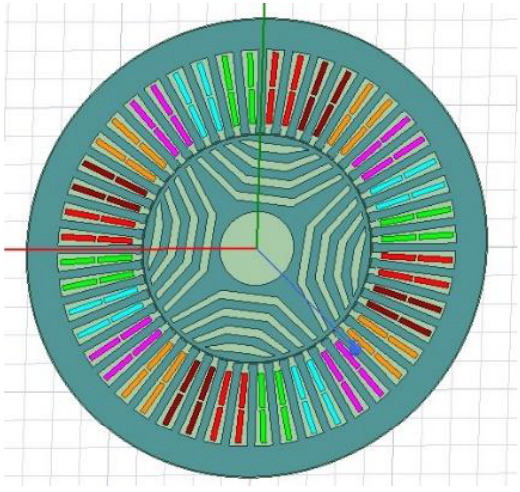
Figure 1. Motor stator and rotor magnetic core design.